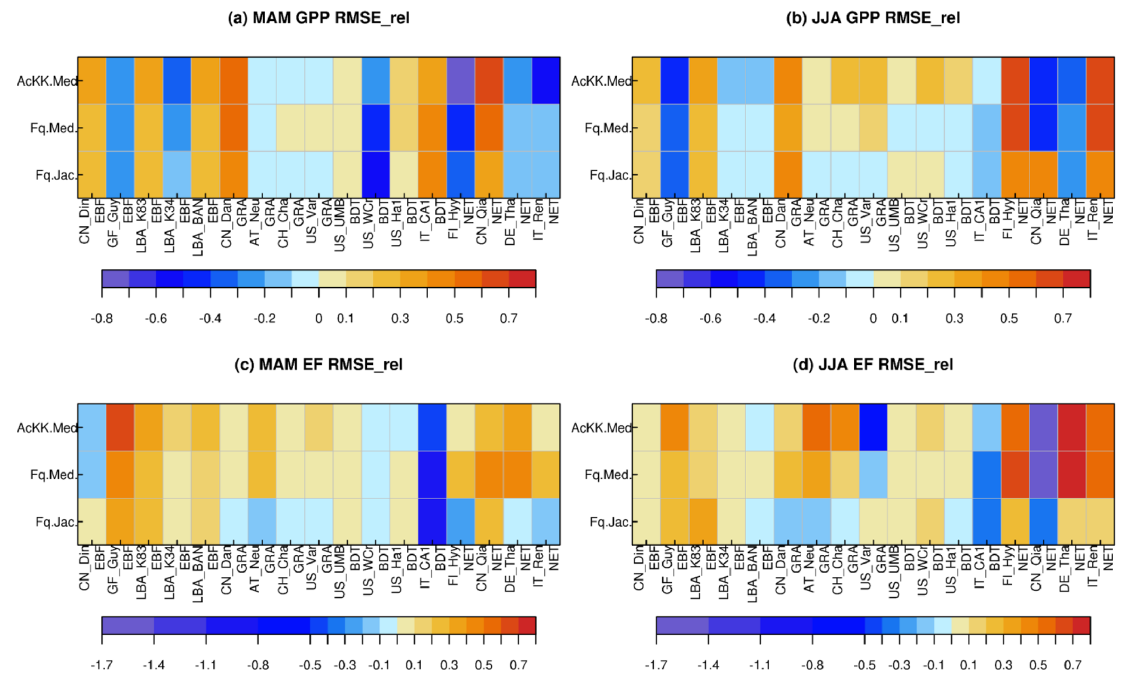
Figure 1. Relative changes in RMSE for each JULES model configuration compared to Collatz with Jacobs (Clz.Jac) for hourly daytime (a) GPP (March–April–May), (b) GPP (June–July–August), (c) EF (March–April–May) and (d) EF (June–July–August). Calculated accord- ing to Eq. (11), positive values (reds and yellows) are where RMSE is lower compared to the Clz.Jac configuration and therefore indicates an improvement compared to the Clz.Jac baseline, and the FLUXNET observations. EBF – broadleaf evergreen tropical tree, GRA – C 3 grassland, BDT – broadleaf deciduous tree, NET – needle leaf evergreen tree. The fit of each model configuration to observations and the RMSE are shown in Fig. S5 (GPP) and Fig. S6